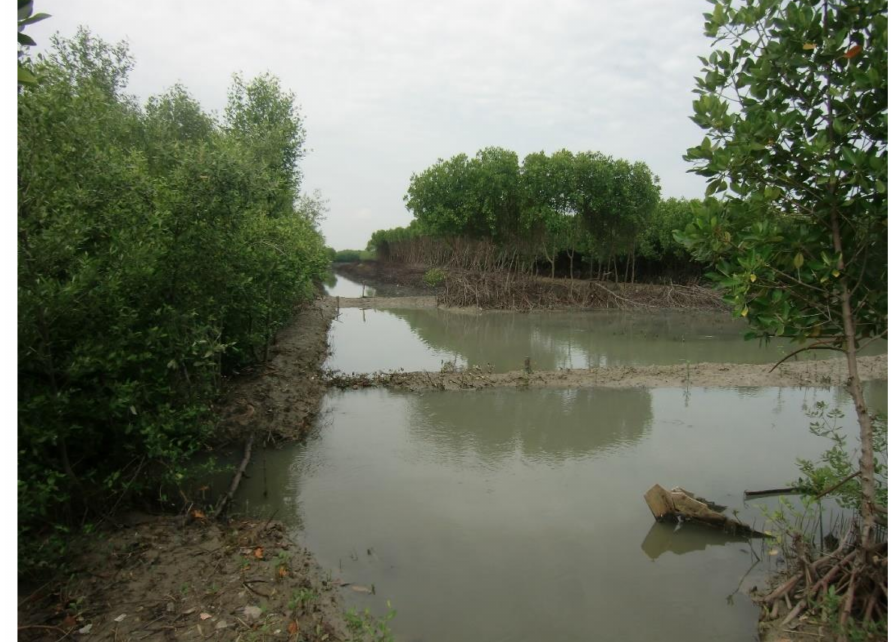
Figure 1. Because of the lack of alternative livelihood options, previously restored mangroves are cleared for pond construction in a restoration area on Java, Indonesia. (Photo credit: